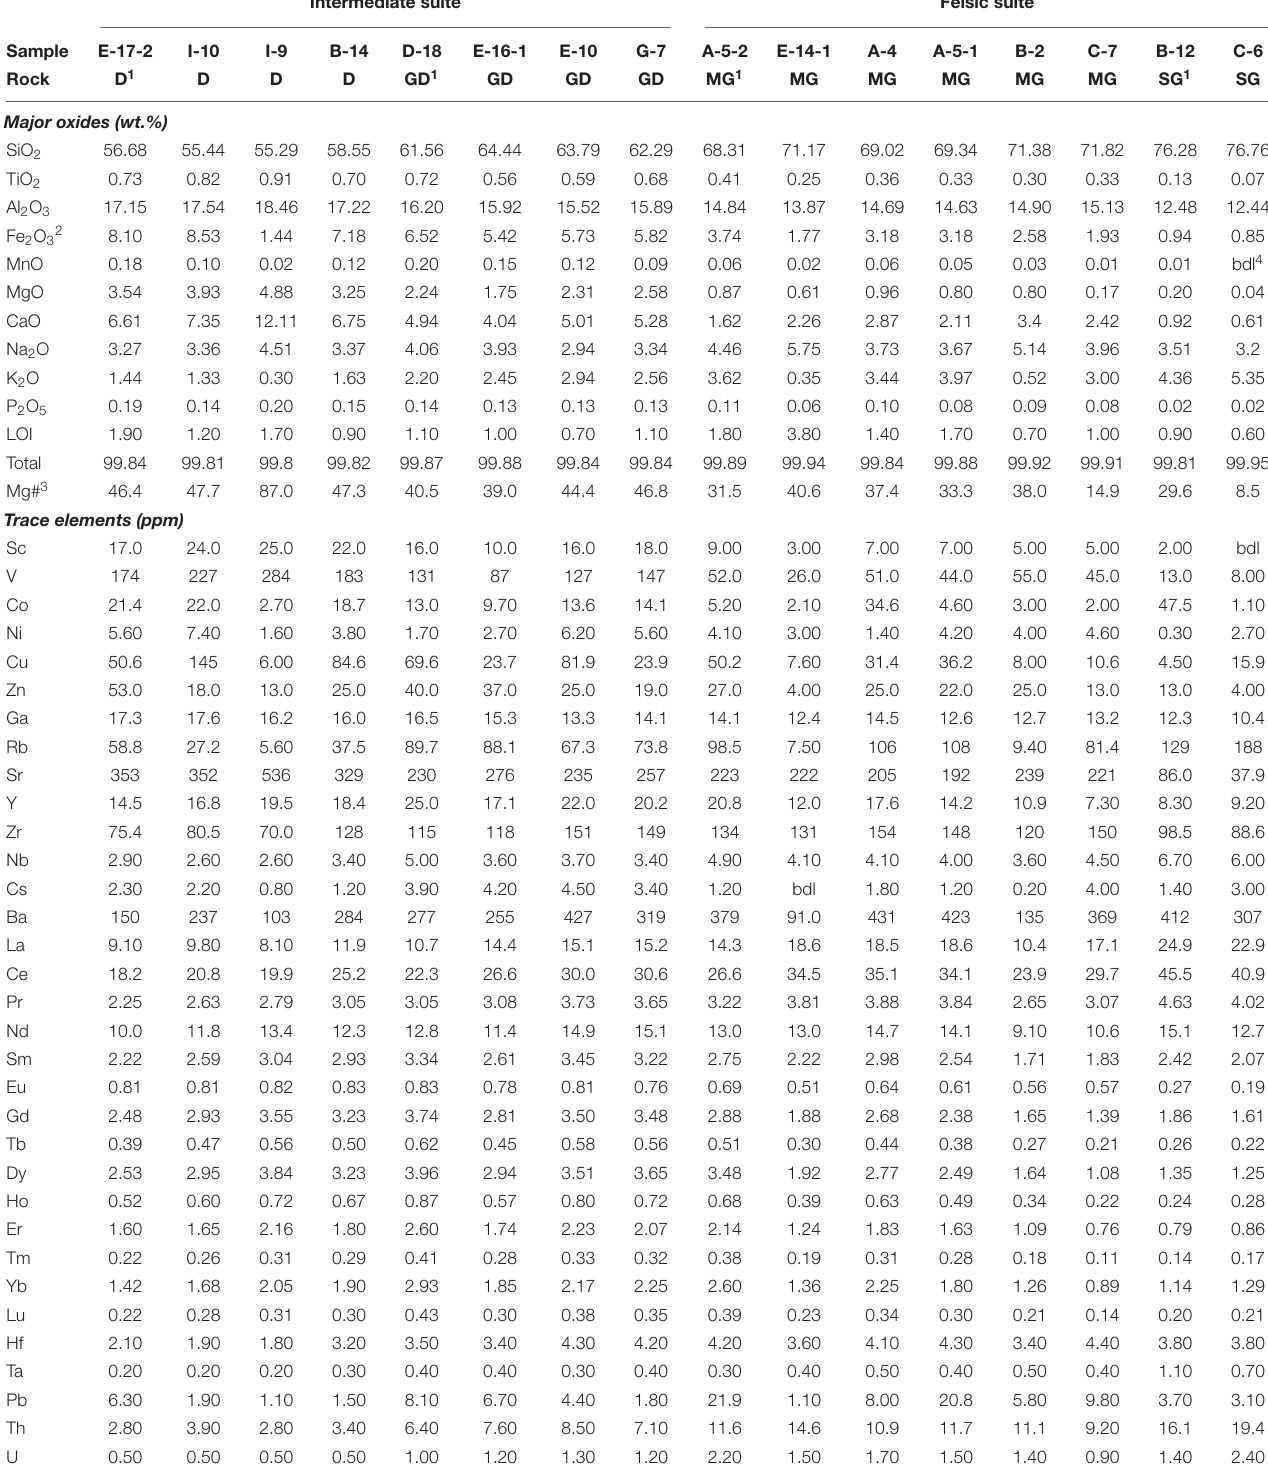
TABLE 1 | Geochemical data for the studied samples from the Takht